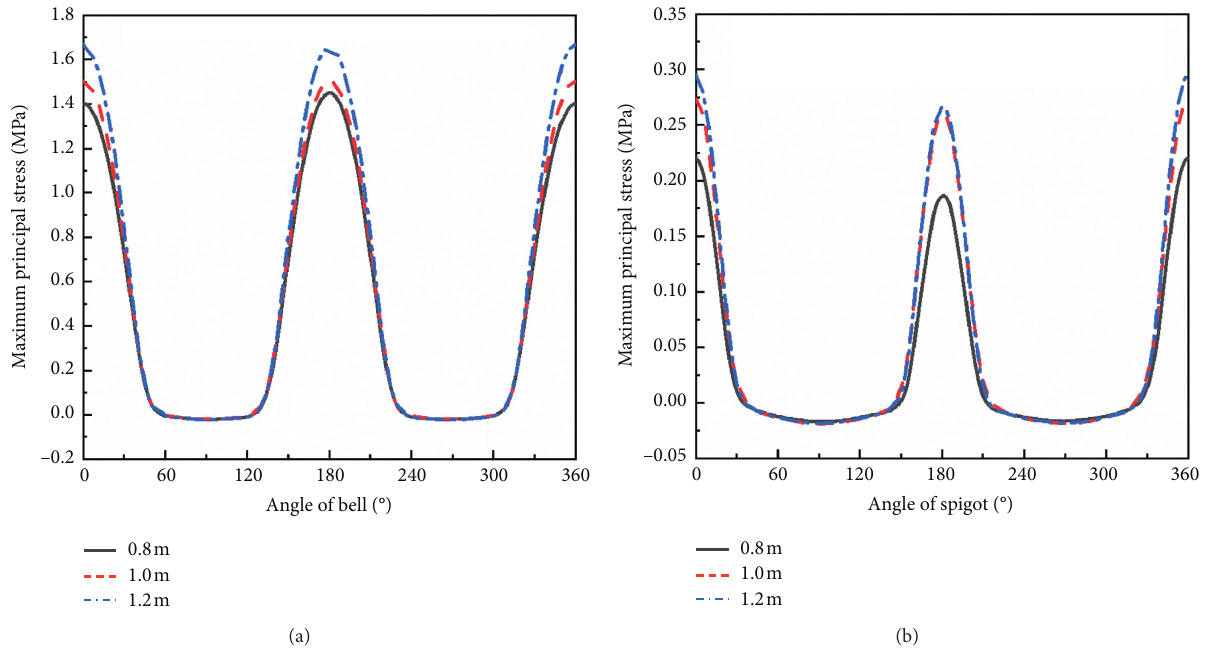
Figure 22: Influence of compaction degree on joint under different compaction degrees rotation and shear